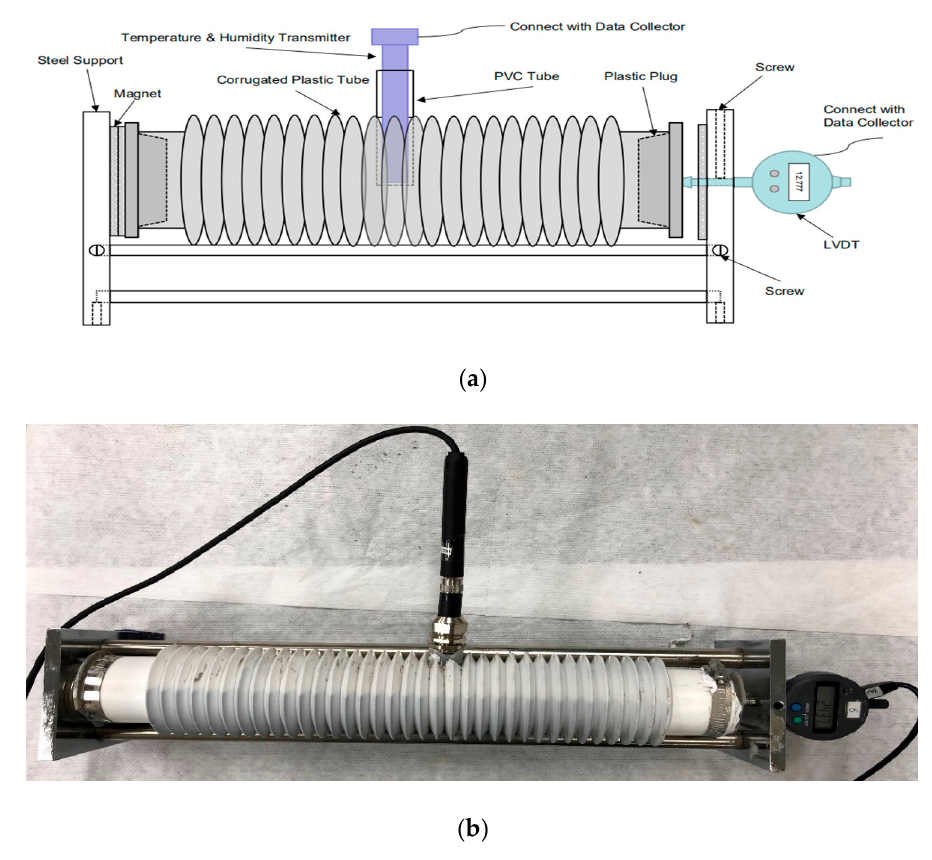
Figure 1. The internal relative humidity, internal temperature, and deformation measurement set-up. ( a ) Design drawing; ( b ) physical